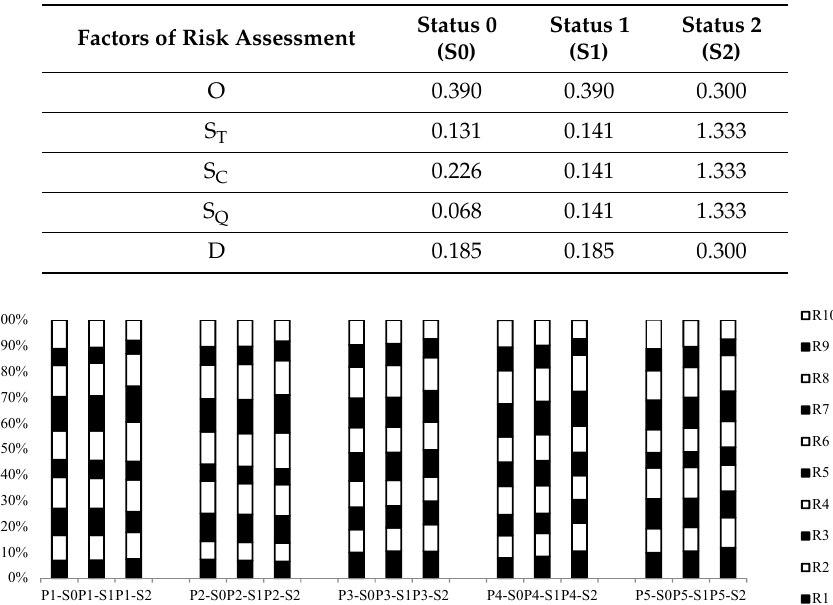
Figure 7. Sensitivity analysis for 5 investment projects. Source: Authors’ elaboration.